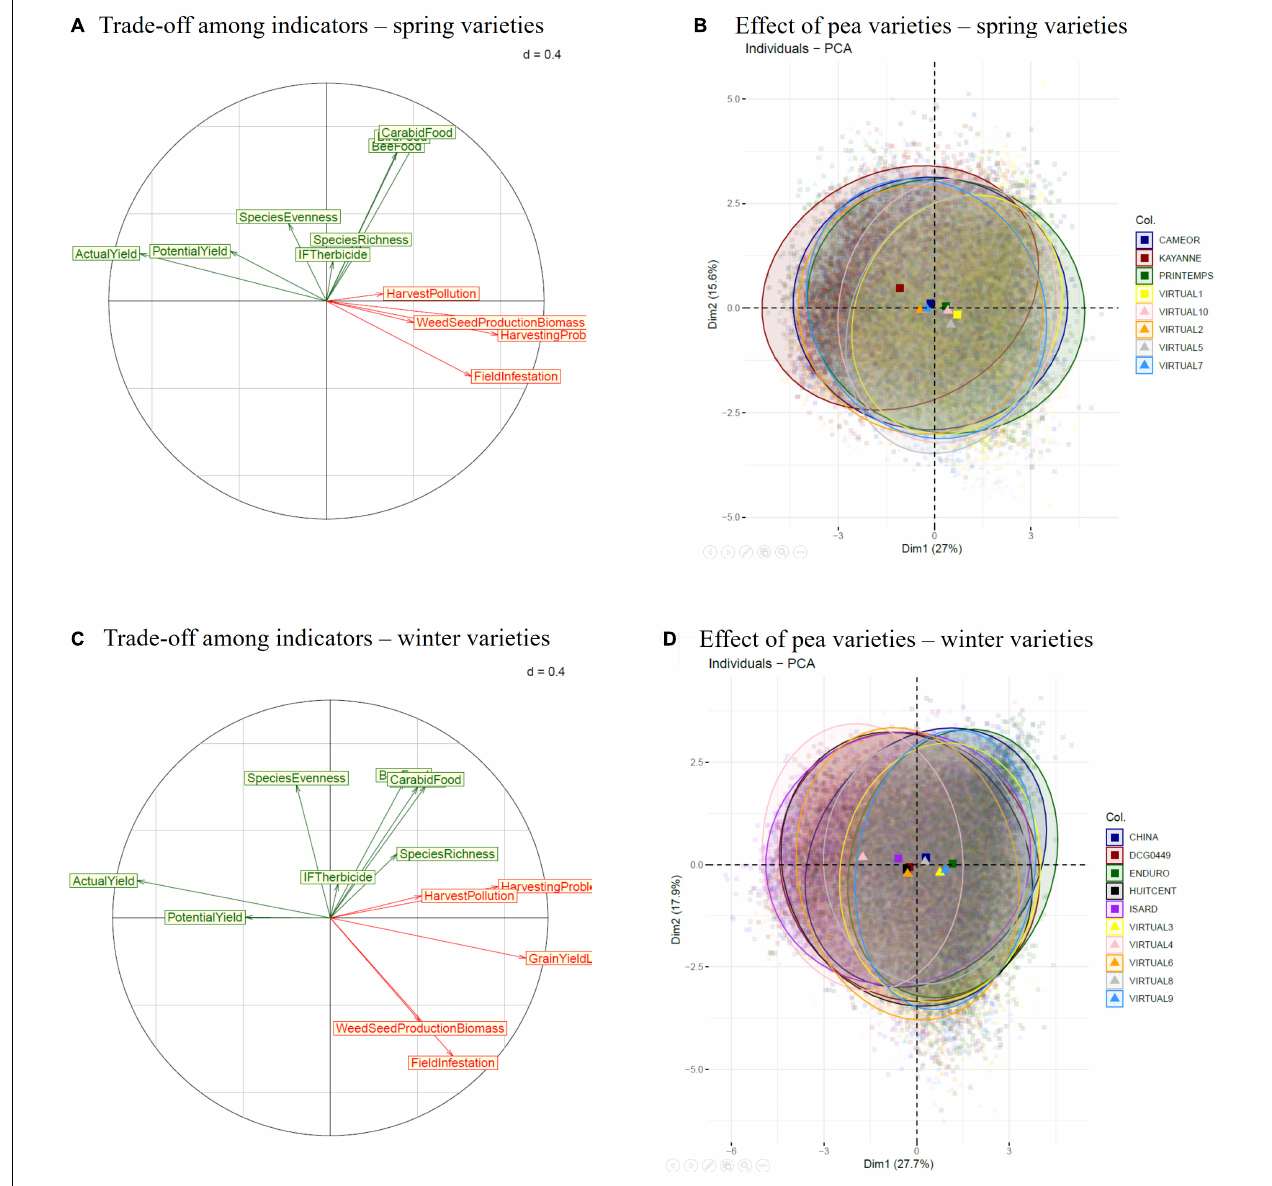
FIGURE 3 | Trade-offs among indicators of pea yield and weed (dis)service identified with Principal Component Analyses (PCA) for spring (A,B) and winter pea varieties (C,D) on the nine simulated situations, using annual simulated data. Pea-yield and biodiversity indicators are shown in green, weed harmfulness for pea production is in red (Colbach, 2020